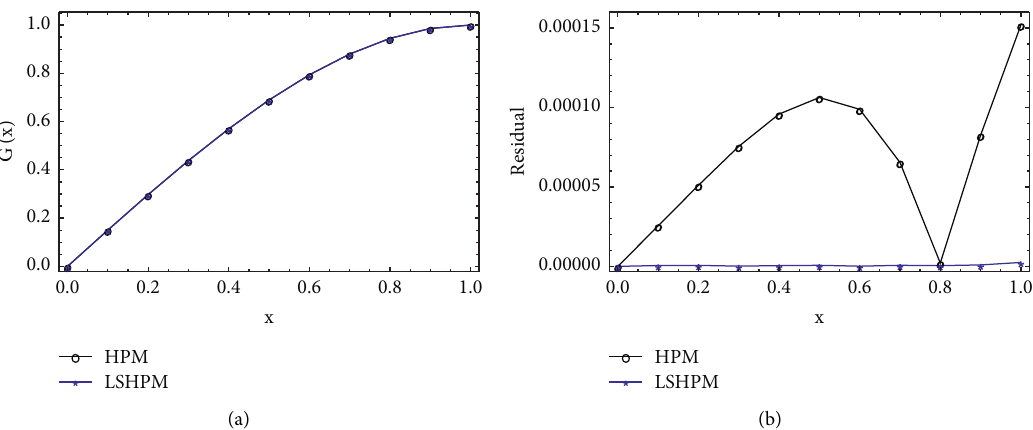
Figure 6: Graphical representation of solutions and errors in Problem 6. (a) Comparison of HPM and LSHPM solutions. (b) Comparison of absolute residual errors of HPM and